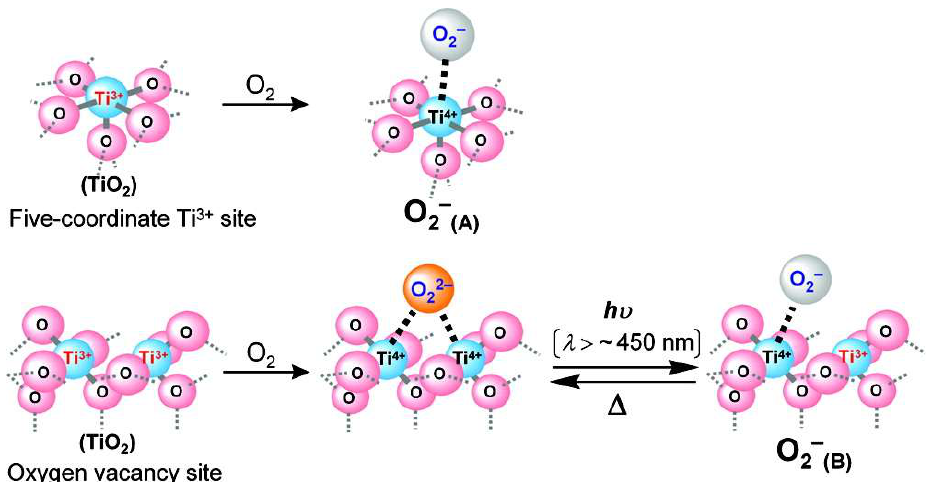
Figure 18. Surface reactivity of reduced Titania under visible light illumination. Reproduced from [147], Copyright 2010, American Chemical Society.